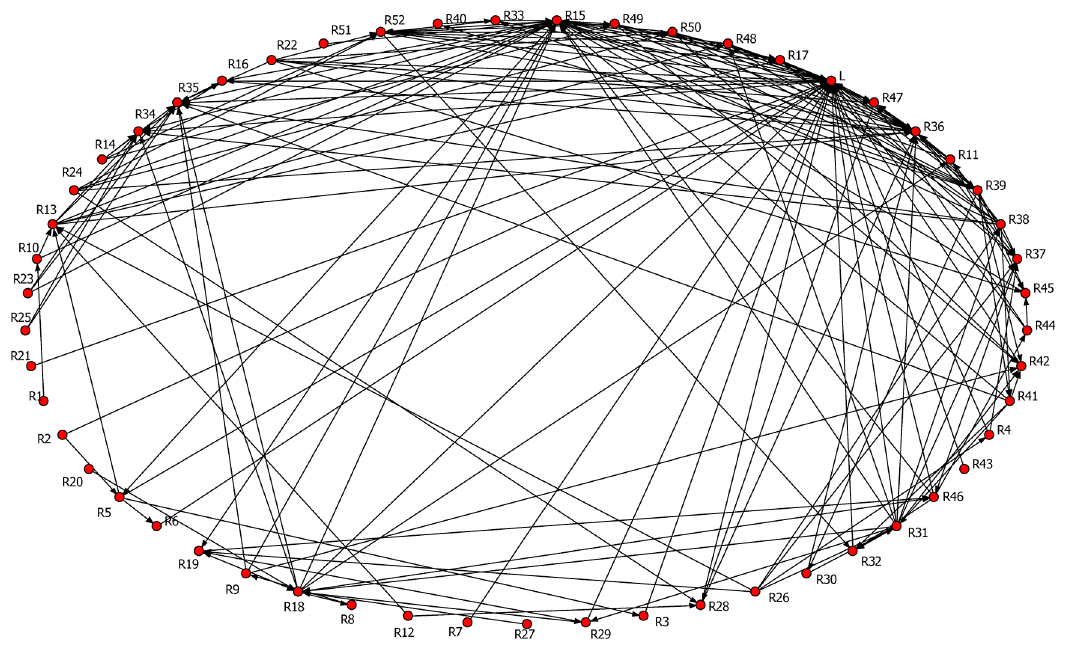
Figure 3. The visualization of complete cost overrun risk propagation network